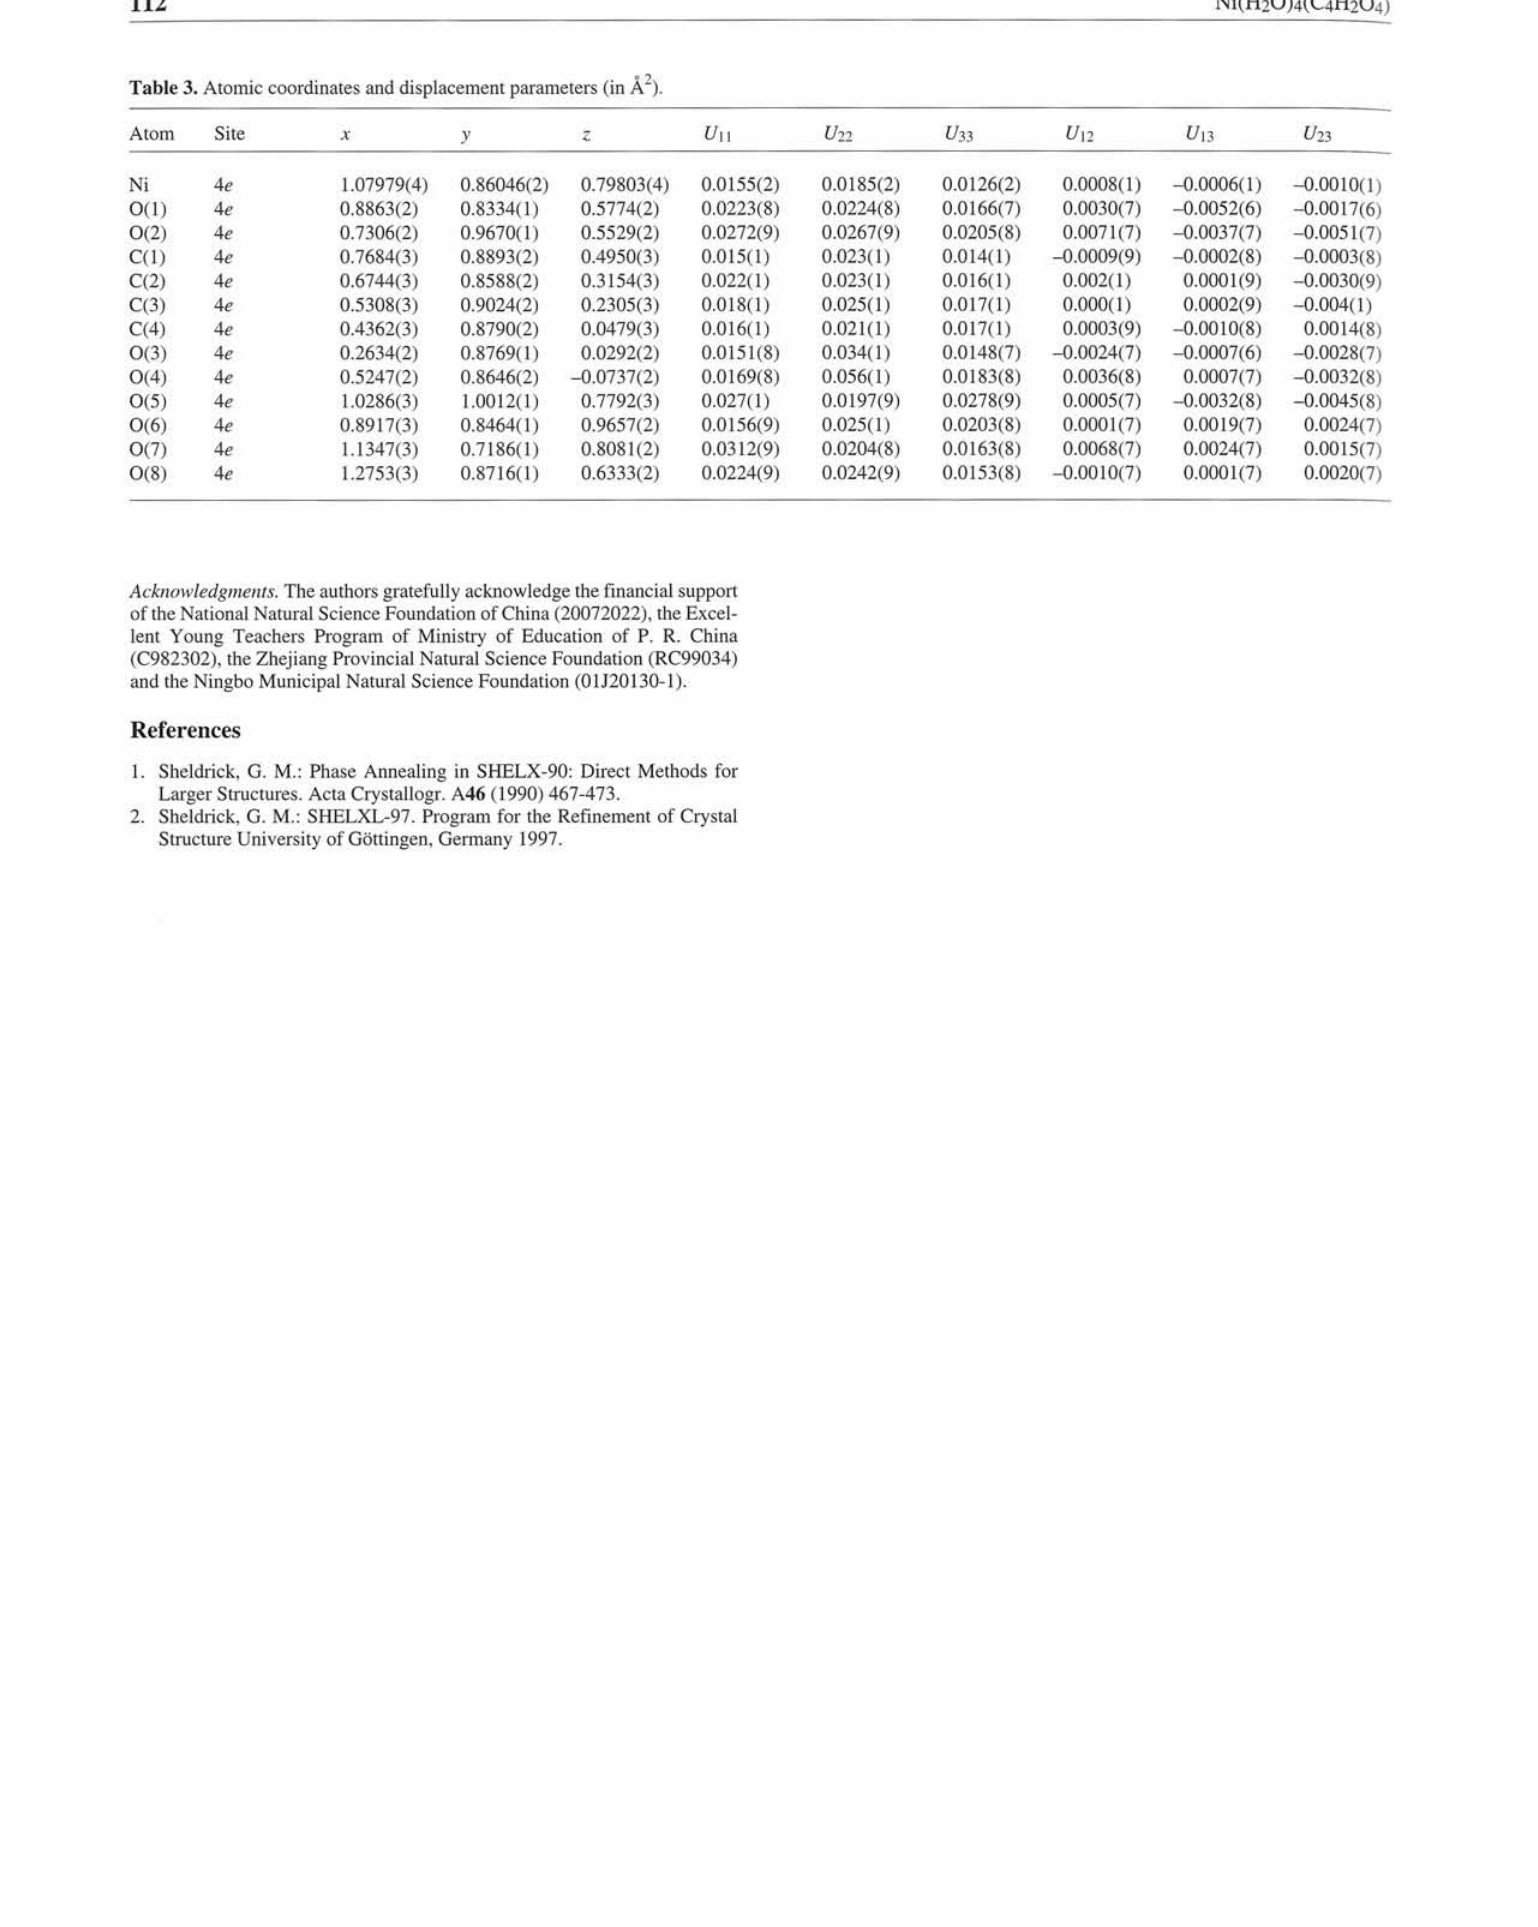
Table 3. Atomic coordinates and displacement parameters (in Â 1